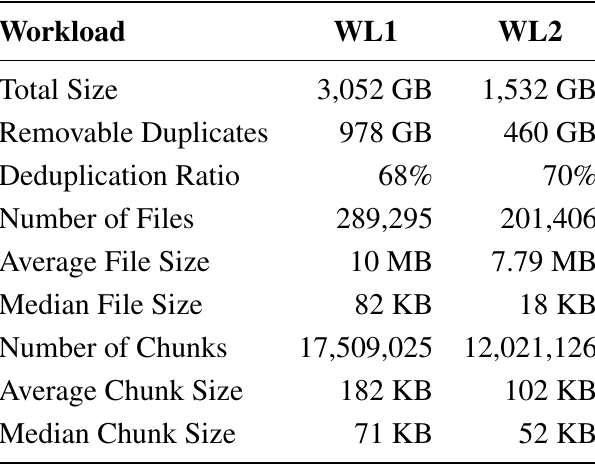
Table 2. Workload